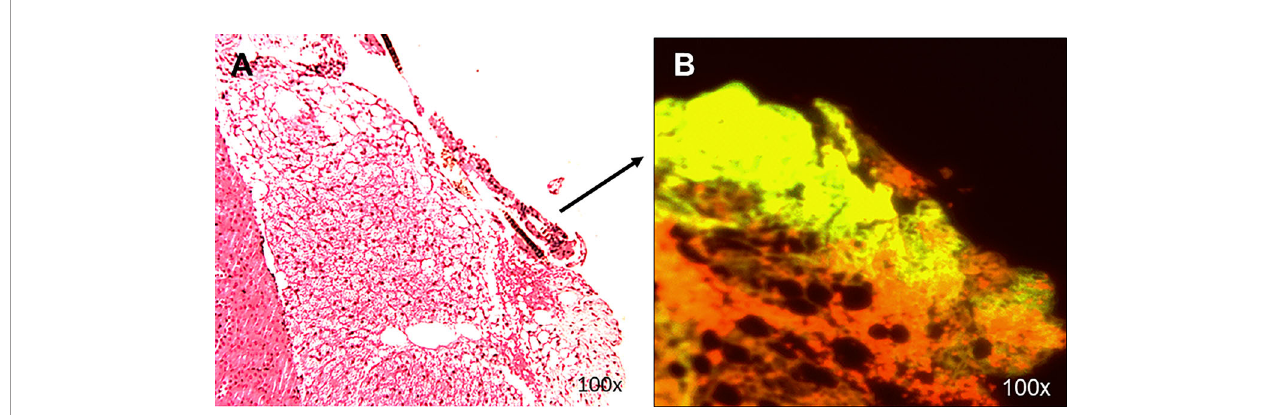
FIGURE 10 | Histology of renal transplants under the capsule. Cells implanted under the kidney capsule were analyzed histologically for thyroid follicles (A) . The presence of follicular structures was further con fi rmed by (B) showing GFP and mCherry overlap fl uorescence of the implanted region with the expression of yellow fl uorescence. This sample of a localized transplant was from 4 weeks